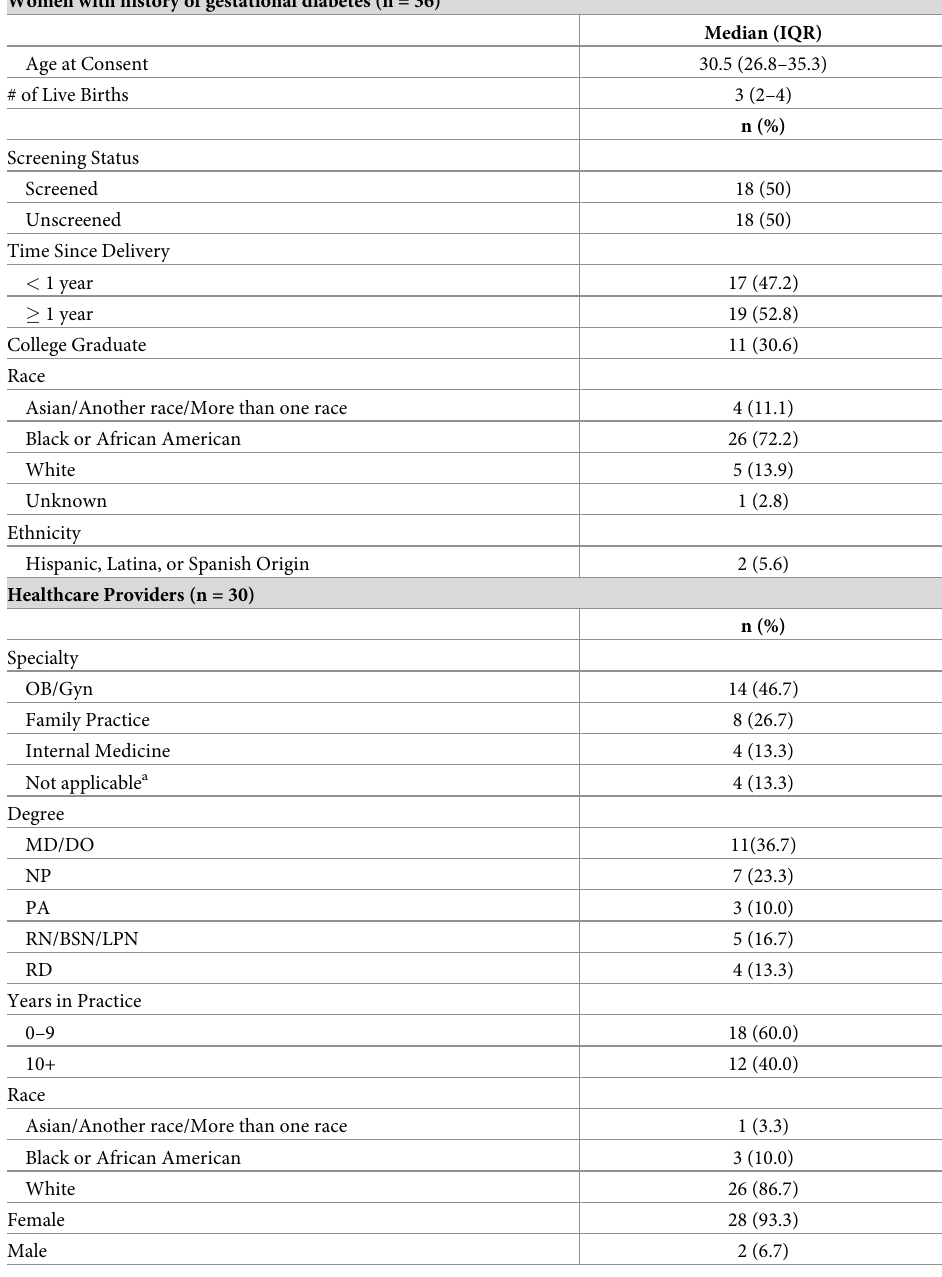
Table 1. Qualitative interview and focus group participant demographic characteristics. Women with history of gestational diabetes (n =